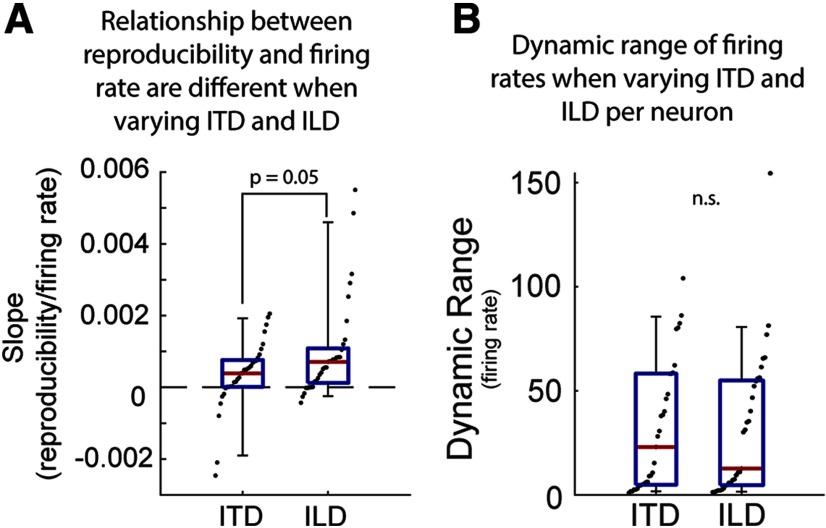
Relationship between reproducibility and response strength depends on the type of binaural cue. A, Comparison of slopes of linear regressions computed for each neuron’s reproducibility as a function of firing rate driven by varying ITD and ILDs. B, Comparison of the dynamic range of firing rates evoked by varying ITD and ILD for each neuron. Red lines indicate the median, blue boxes represent the first and third quartile, and whiskers are the 5th and 95th percentiles.